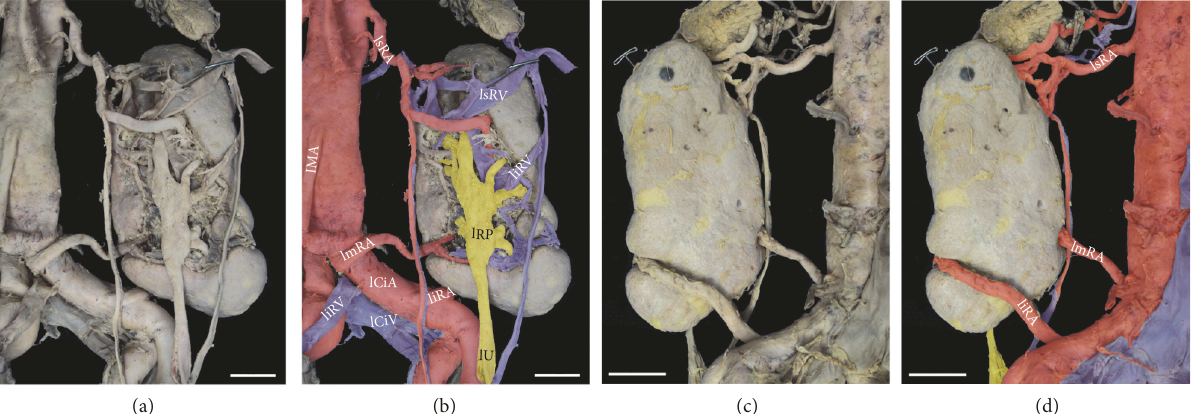
Figure 3: Ex situ left kidney exhibits anatomical variations . Anterior (a, b) and posterior (c, d) views of the left kidney. Arterial, venous and uretericsystems (b, d) are pseudocolorized in red (arterial),blue (venous) and yellow (ureteric).Renal veins (lsRV, liRV) are reflectedto better illustrate the arterial pattern. Image scale bar = 2